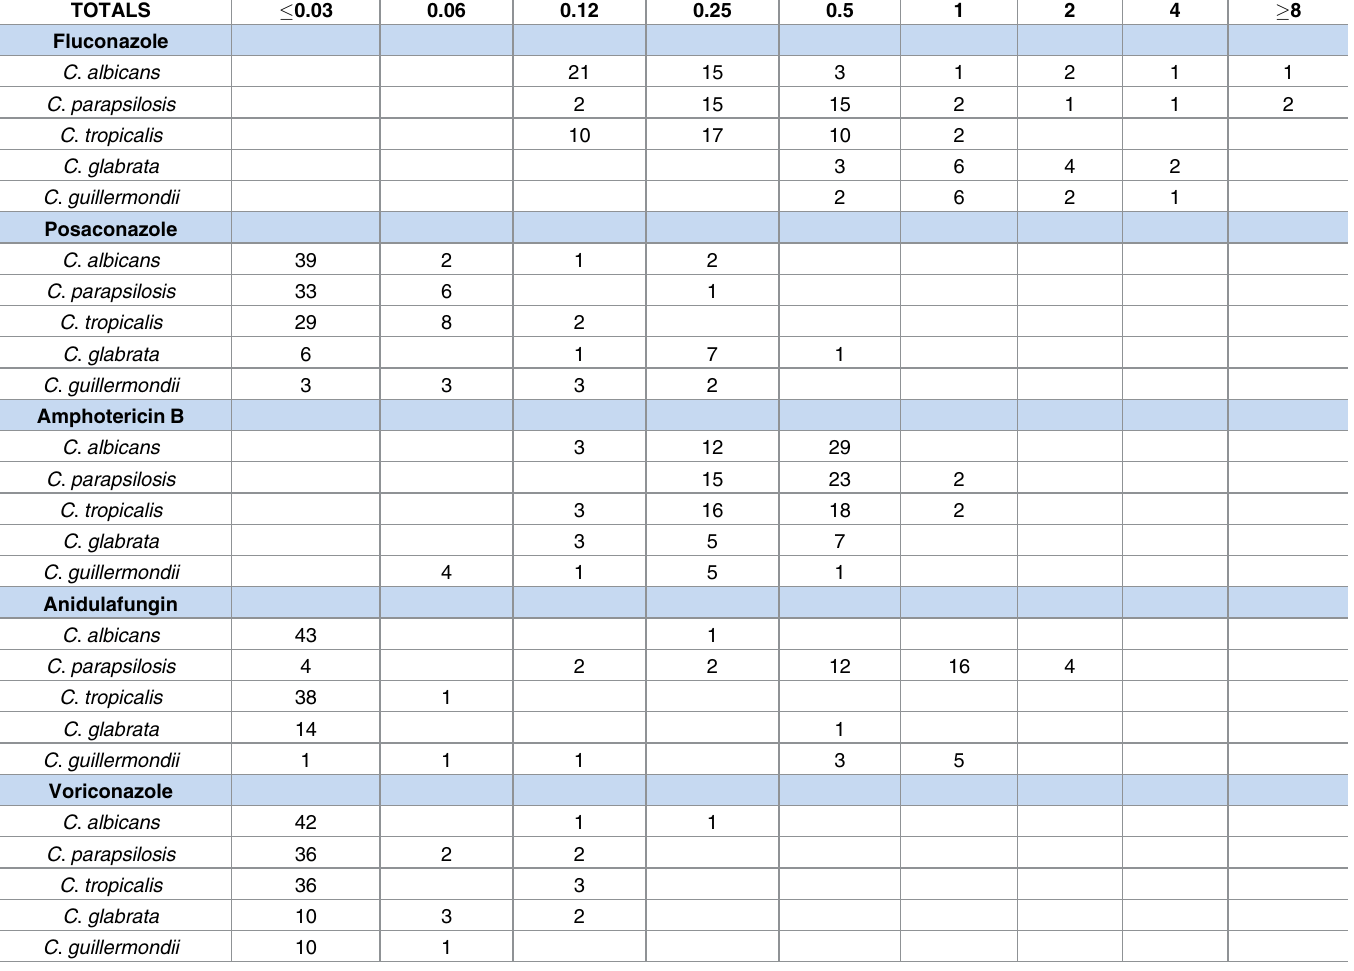
Table 3. MIC distribution of antifungal drugs against 5 most common Candida